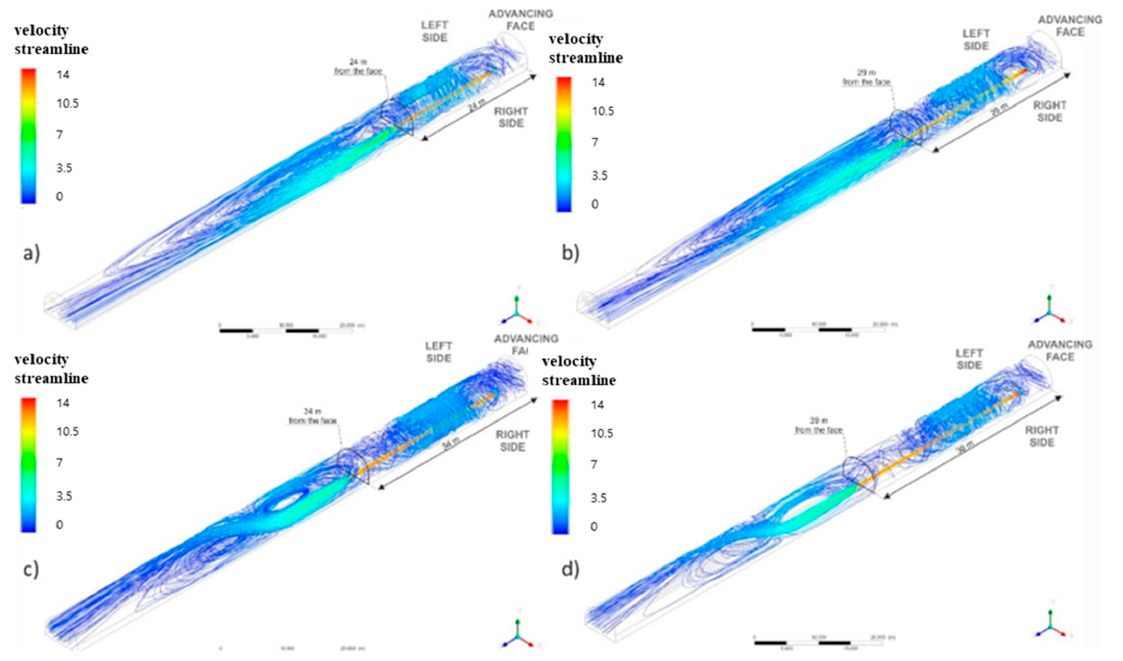
Figure 9. Numerical results of the velocity streamlines ( a ) L 0 = 5m, ( b ) L 0 = 10m, ( c ) L 0 = 15m, ( d ) L 0 = 20m [73].